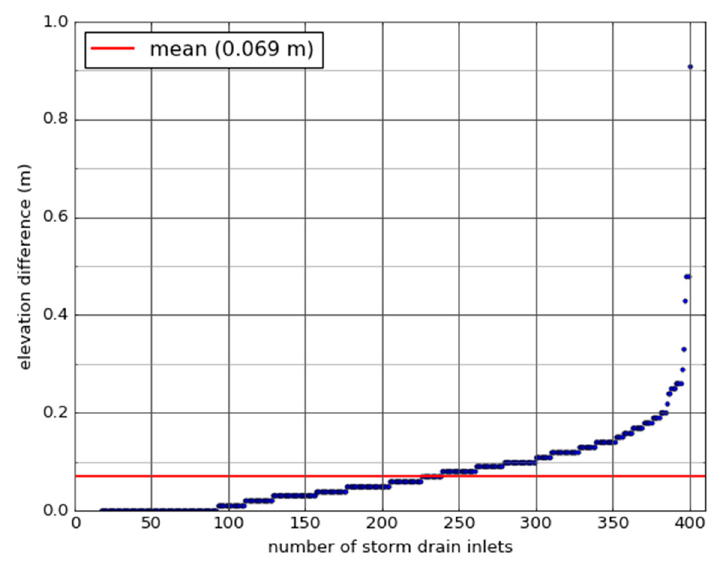
Figure 6. Difference of elevation between the initial storm drain inlet location and adjusted one.